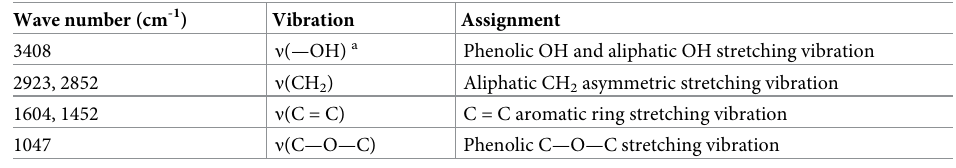
Table 4. Peaks and assignment of FT-IR spectra for